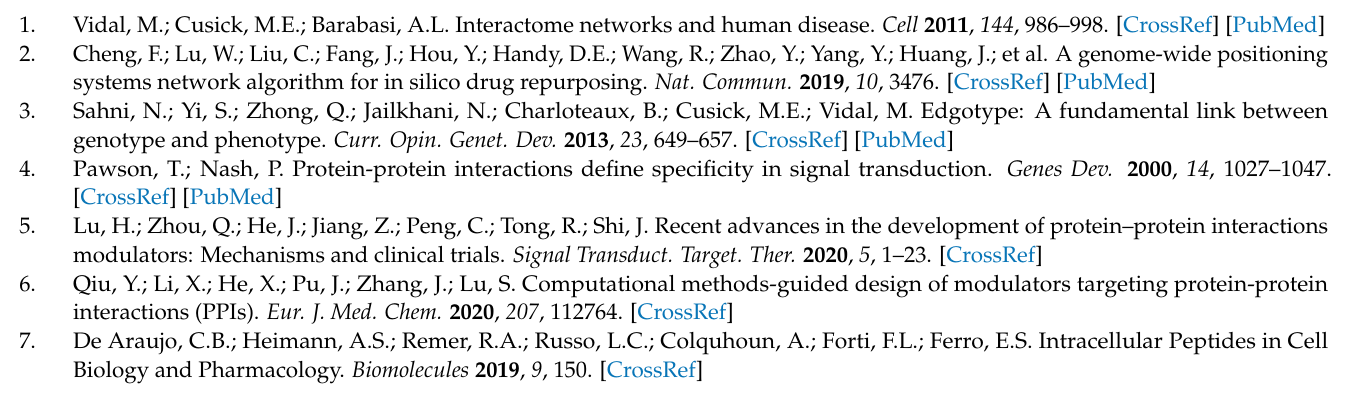
Prediction of disordered regions for each peptide, aligned with respect to the last residue, obtained with the IUPred2A server. Supplemental Figure S4. Disordered region prediction from the Dis- EMBL server for indicated peptides. Supplemental Figure S5. Secondary structure prediction results from the PEP-FOLD3 tool for VFD7. Supplemental Figure S6. Selected models for selected VFD7 derived